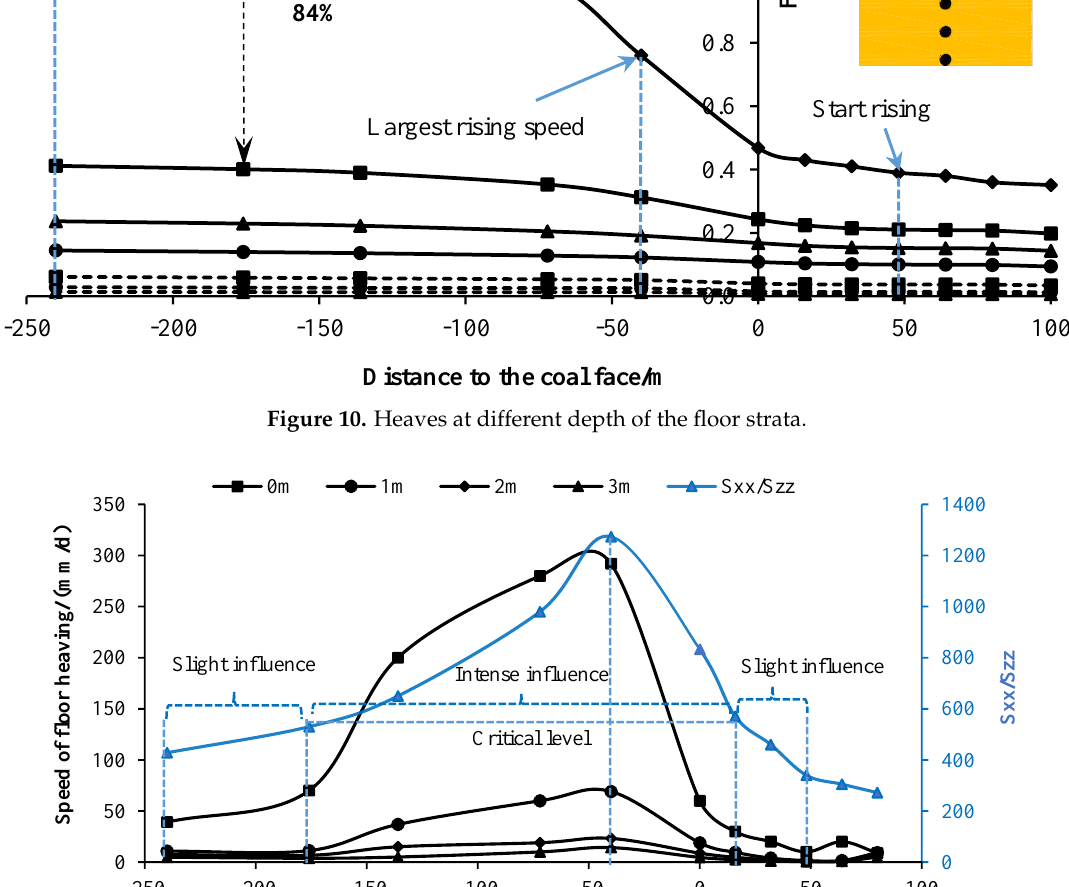
Figure 11. Heaving speed and stress ratio at different depth of the floor strata.